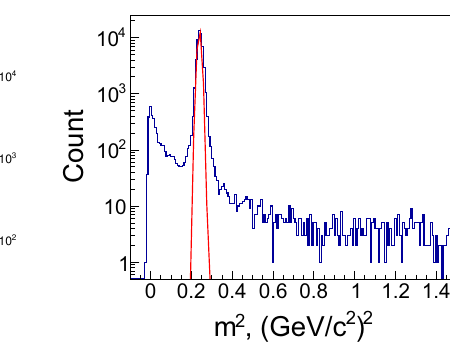
Figure 3: m 2 vs p Figure 4: PDG-kaons, 0 . 3 < p < 0 . 4 GeV /